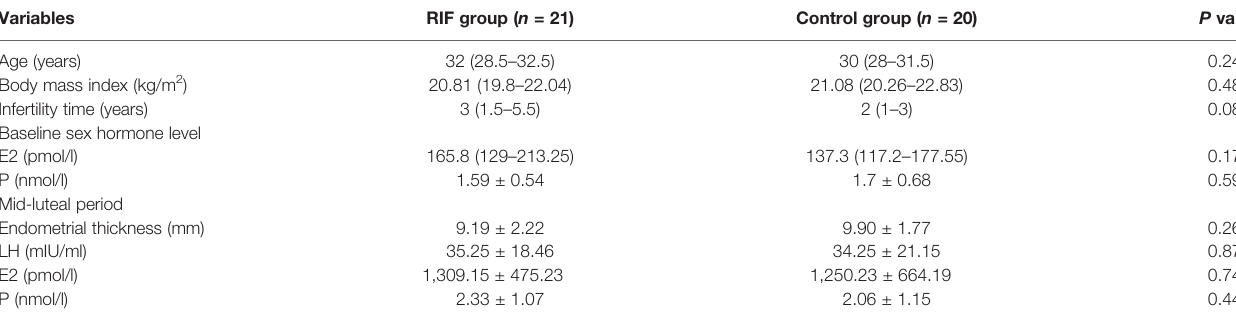
TABLE 1 | Baseline characteristics of the study